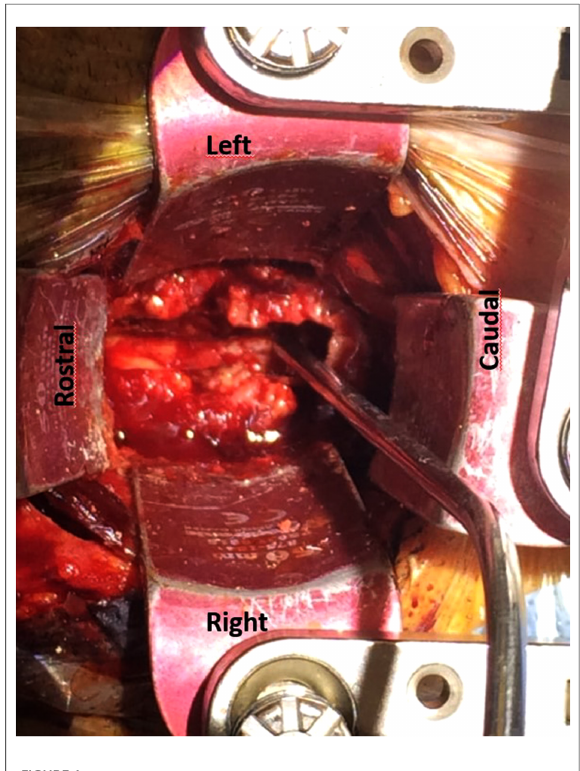
FIGURE 1 Operative image of case 4: an anterior view of the cervical spine with an anterior transvertebral decompression in the midline of vertebral bodies and intervertebral disc C4 – C7. Through the trench the epidural space is reached with the dura mater as posterior